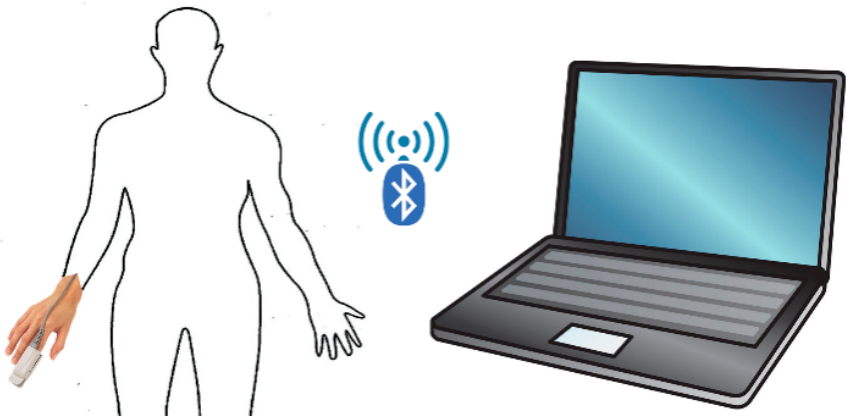
Figure 2. Connectivity of the prototype photoplethysmography (PPG) system.